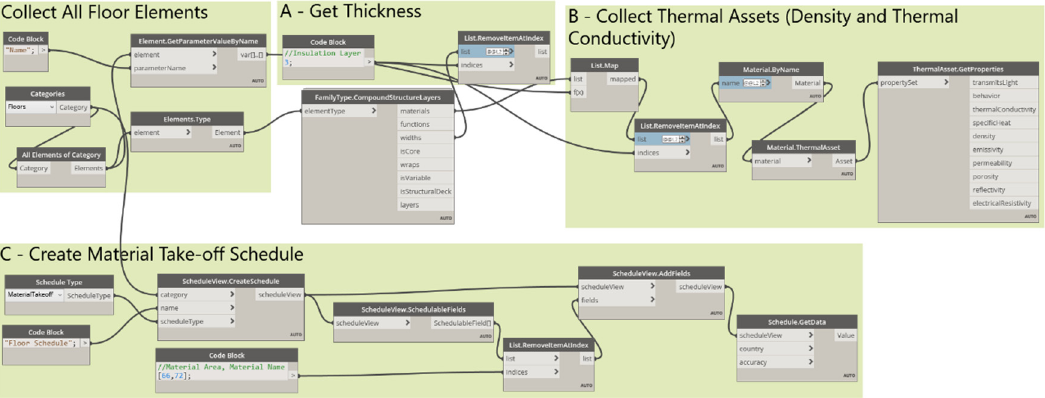
Figure 4. Proposed Dynamo Workflow for Reading Data from the Revit Model. ( A ) Obtaining thickness; ( B ) collecting properties if material; ( C ) creating material take-off.